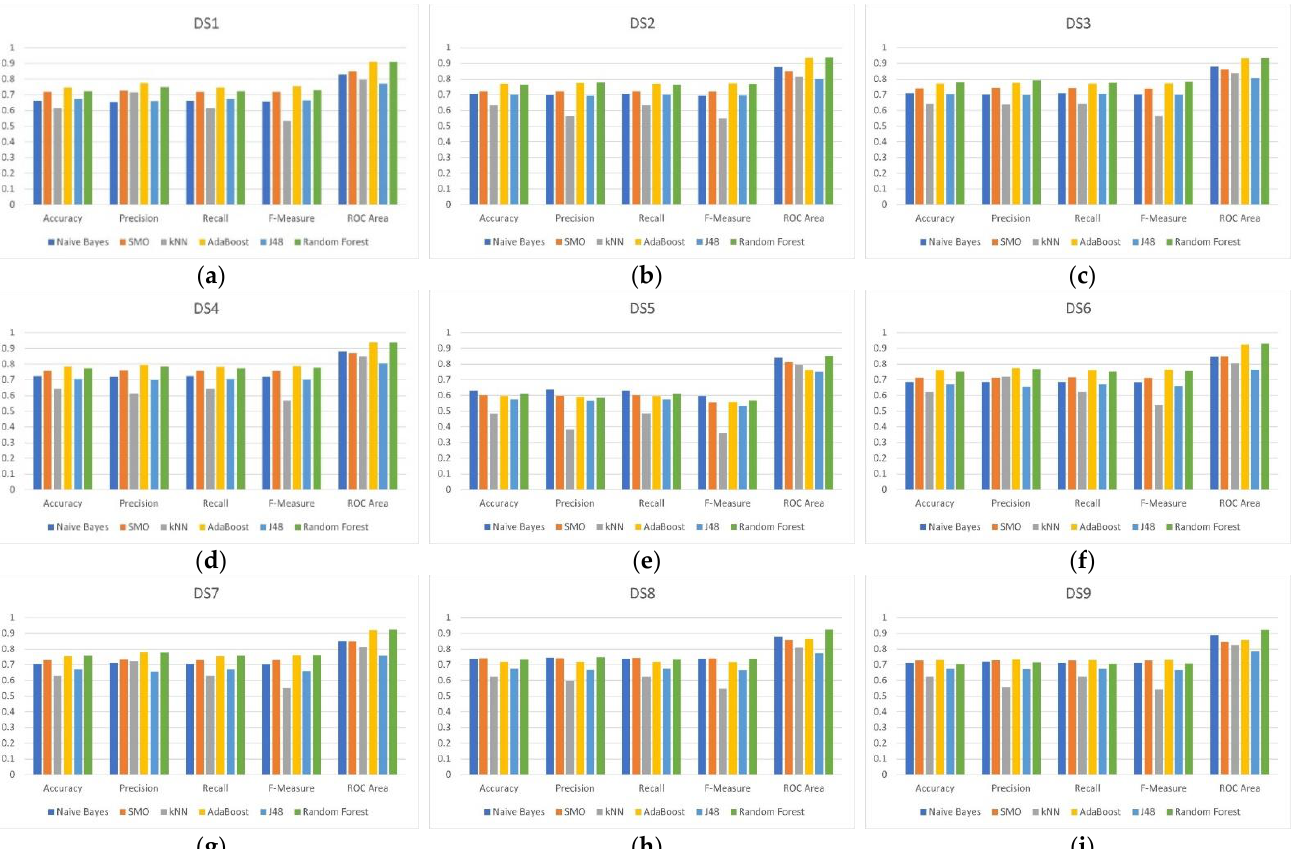
Figure 3. Performance of classifiers in the nine datasets: ( a ) Original dataset; ( b ) without the 100 least correlated features with the class; ( c ) without the 150 least correlated features with the class; ( d ) without the 200 least correlated features with the class; ( e ) without the 271 least correlated features with the class; ( f ) without the 100 least informative features; ( g ) without the 150 least informative features; ( h ) without the 200 least informative features; ( i ) without the 265 least informative features.